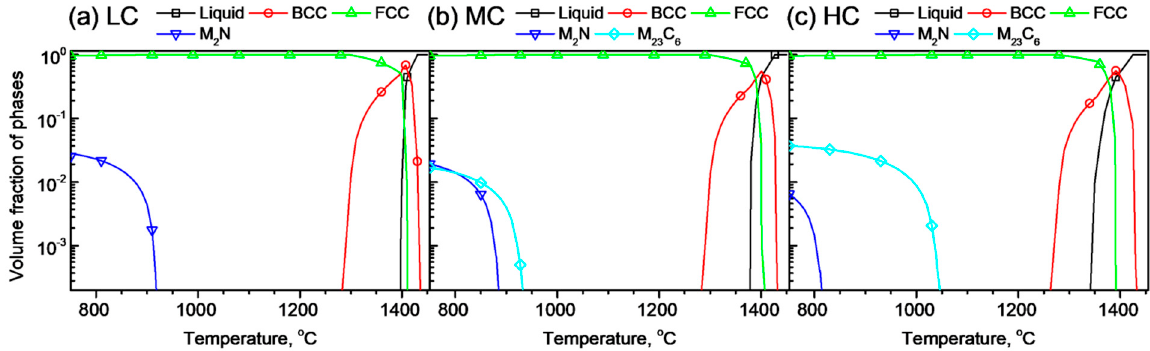
Figure 1. Equilibrium phase fractions of the ( a ) LC, ( b ) MC, and ( c ) HC alloys defined in Table 1 as a function of temperature calculated using Thermo-Calc software.